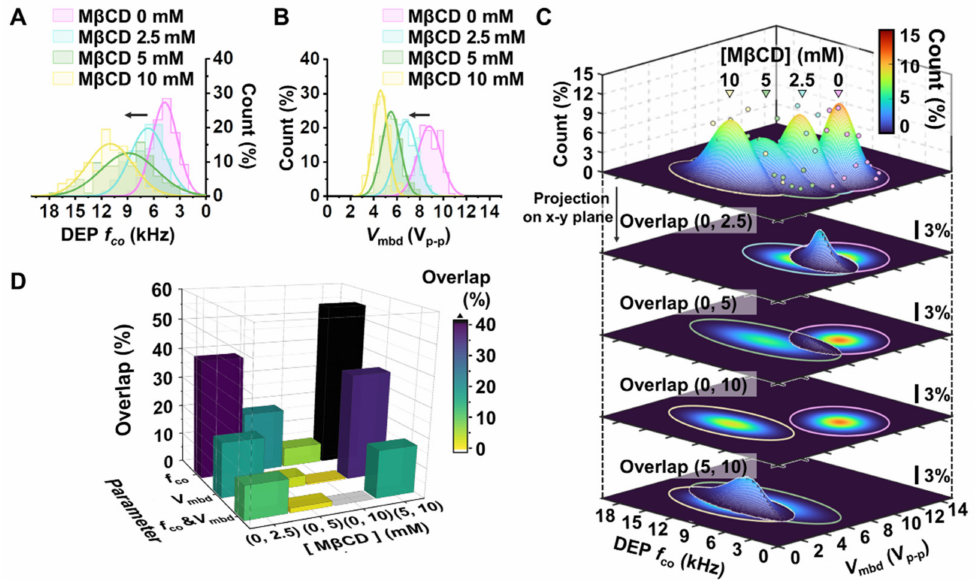
Figure 4. Electrical phenotyping of MCF-7 cells in response to M β CD treatment. ( A , B ) Representative histogram and Gaussian normal distribution concerning DEP f co parameter ( A ) and V mbd ( B ). Each histogram was plotted from data of 136, 129, 102, and 82 cells for 0, 2.5, 5, and 10 mM of M β CD treatment condition, respectively. ( C ) Representative 2D Gaussian distribution using both f co and V mbd for the M β CD-treated cell population. Each dot denotes the bin frequency (%) of DEP f co and V mbd in each cell population. Each color line represents the 99.9% contour line of the 2D Gaussian distribution with respect to M β CD treatment concentration. This distribution was projected onto the DEP f co - V mbd plane and can be expressed as the density plot of the 2D Gaussian distribution. The calculated overlap count between the two distributions is represented on the projection plane. ( D ) The overlapping occupancy (%) of the population distribution between no treatment and treat- ment used the parameters DEP f co , V mbd , and both f co and V mbd . The overlapping comparison of